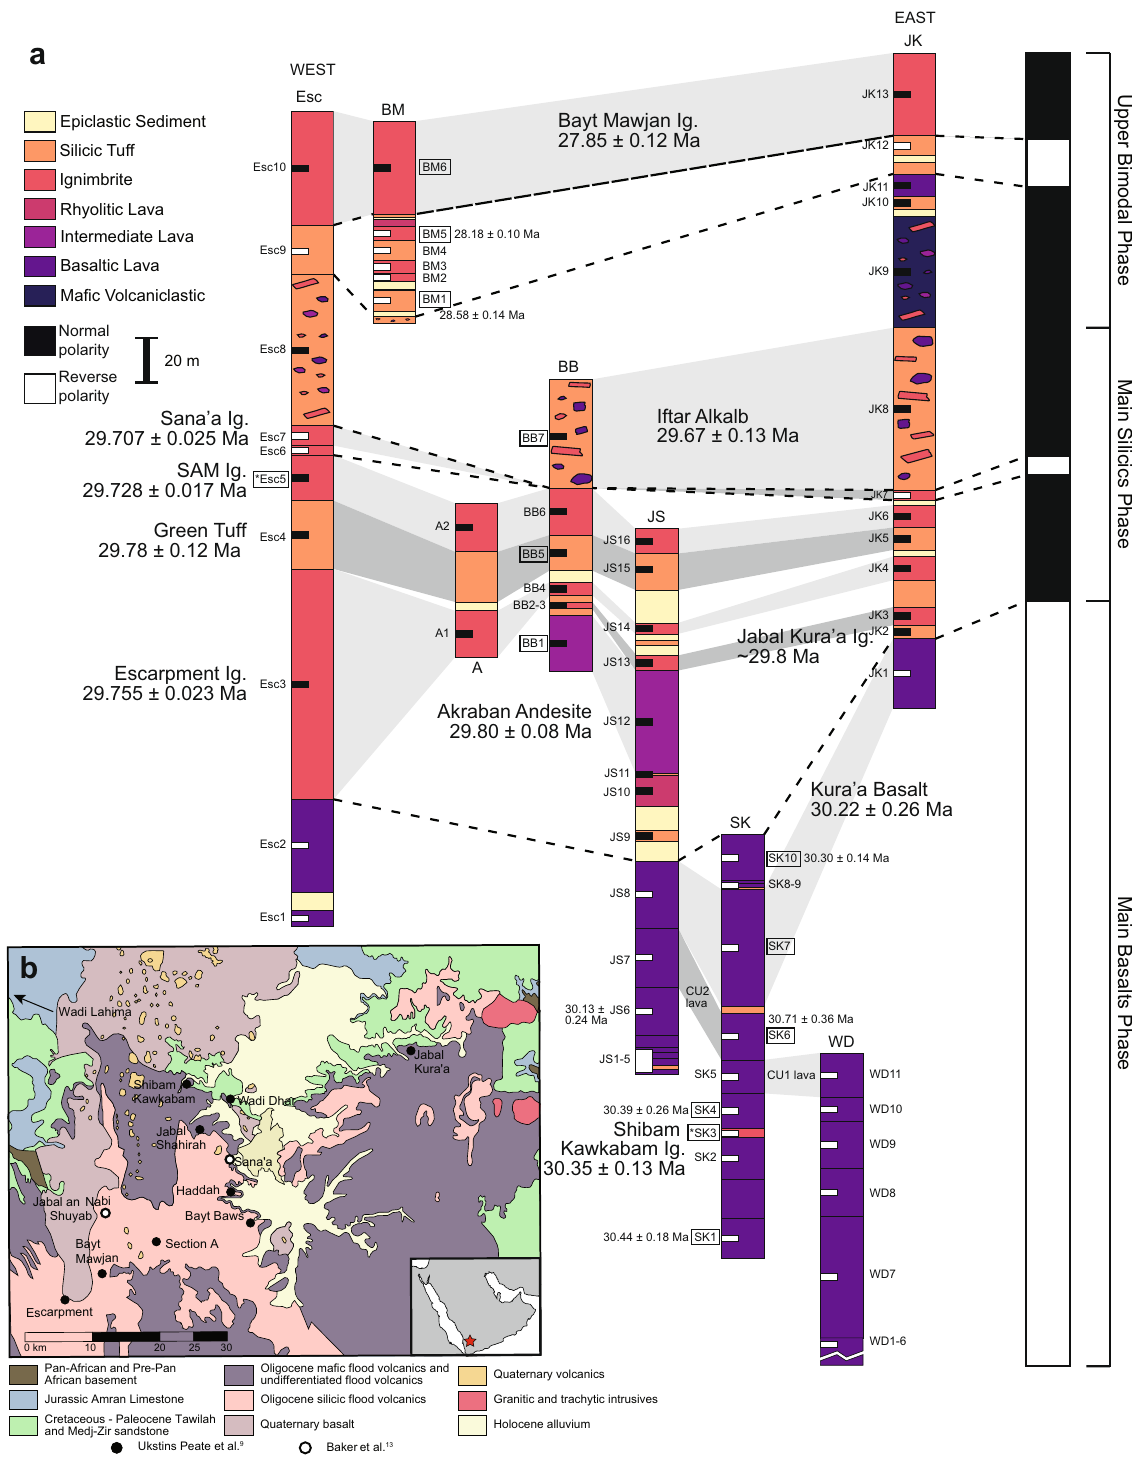
Fig. 1 Samples pro fi les of the Northern Yemen volcanic units. a Schematic volcanic stratigraphy and paleomagnetic sampling pro fi les of volcanic units emplaced during Oligocene bimodal volcanism in Northern Yemen (modi fi ed from Ukstins Peate et al. 9 ). Unit thicknesses and lithologies are from Ukstins Peate et al. 9 and paleomagnetic data are from Riisager et al. 8 . Section abbreviations, from west to east, are: Esc Escarpment, BM Bayt Mawjan, A Section A, BB Bayt Baws, JS Jabal Shahirah, SK Shibam Kawkabam, WD Wadi Dhar, JK Jabal Kura ’ a. Ι gnimbrite is abbreviated as Ig. Sites are annotated with magnetic polarity data 8 where white and black are reverse and normal polarity, respectively. Sites outlined in boxes denote those dated by 40 Ar/ 39 Ar (refs. 8,10,13 ) or 206 Pb/ 238 U geochronology (data presented here) and ages are shown in detail in Fig. 2. Ages and sites denoted with an asterisk (*) are from correlative units in Ethiopia 10 . Sampling locations are shown in b 9 with the Sana ’ a region, Yemen indicated with a star.